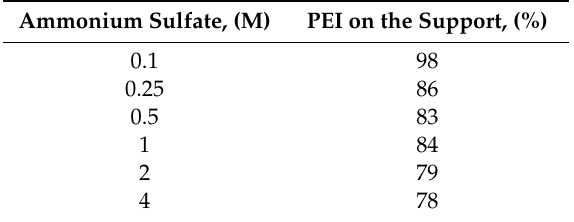
Table 1. E ff ect of the incubation in solutions presenting di ff erent concentrations of ammonium sulfate on the PEI that remained attached to the octyl-VS-CALA biocatalyst, determined by titration of the primary amino groups using 2,4,6-trinitrobenzene sulfonic acid (TNBSA) (see Material and Methods).